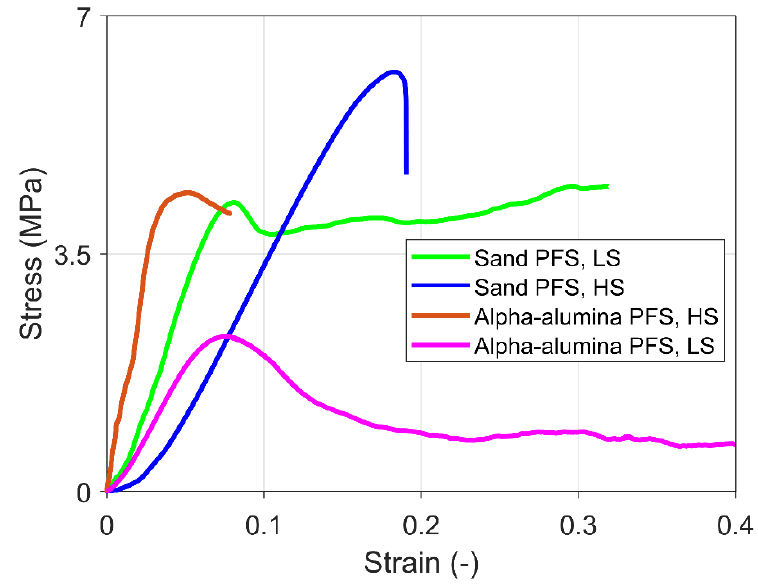
Figure 6. Representative stress-strain characteristics for different frozen PFS under a high strain (HS) rate of 10 −2 s − 1 and low strain (LS) rate of 10 −3 s −1 .